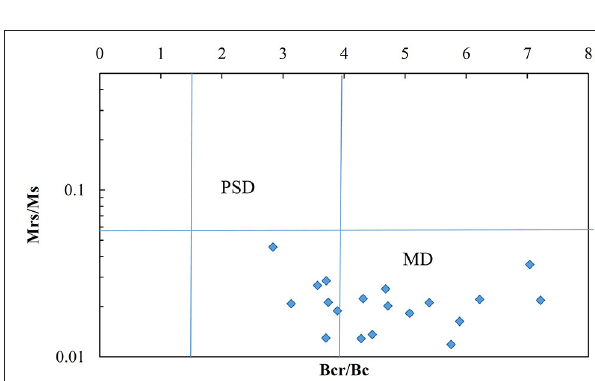
FIGURE 5 | Day plot showing the ratio saturation remanence (Mrs) by saturation magnetization (Ms) against the ratio remanent coercivity (Bcr) by ordinary coercivity (Bc). Each point corresponds to one of the core samples selected for magnetic mineralogy measurements. PSD, Pseudo Single Domain; MD,